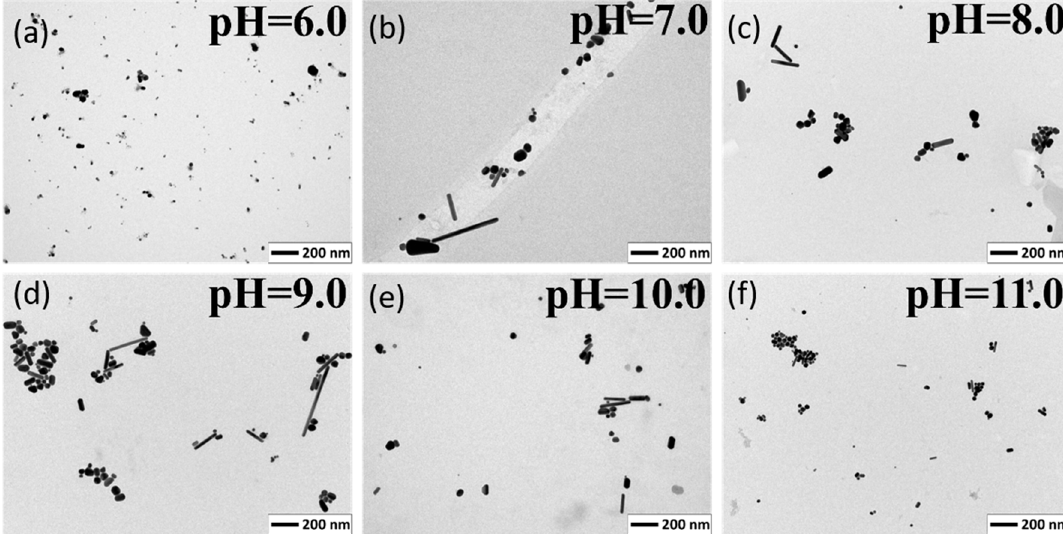
Figure 2. TEM images of the silver nanoparticles reduced by citric acid at pH 6.0 to 11.0. ( a ) pH = 6.0; ( b ) pH = 7.0; ( c ) pH = 8.0; ( d ) pH = 9.0; ( e ) pH = 10.0; ( f ) pH = 11.0.